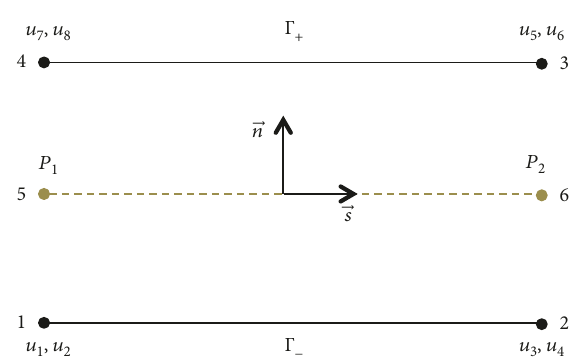
Figure 3: Cohesive fi nite element equipped with pore fl uid/stress fi nite element (PFS-Cohesive) in a rock